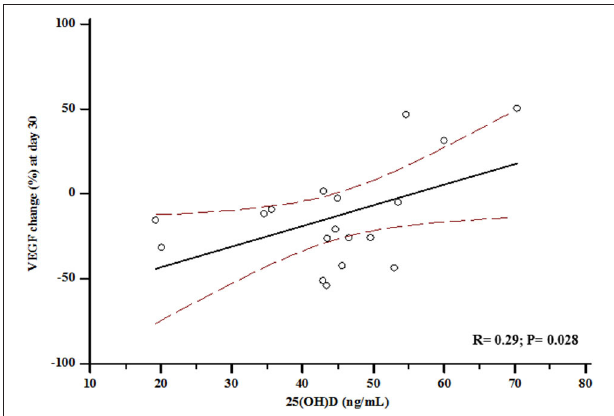
FIGURE 5 | Association between vitamin D status at baseline and percent change of Vascular Endothelial Growth Factor (VEGF) at